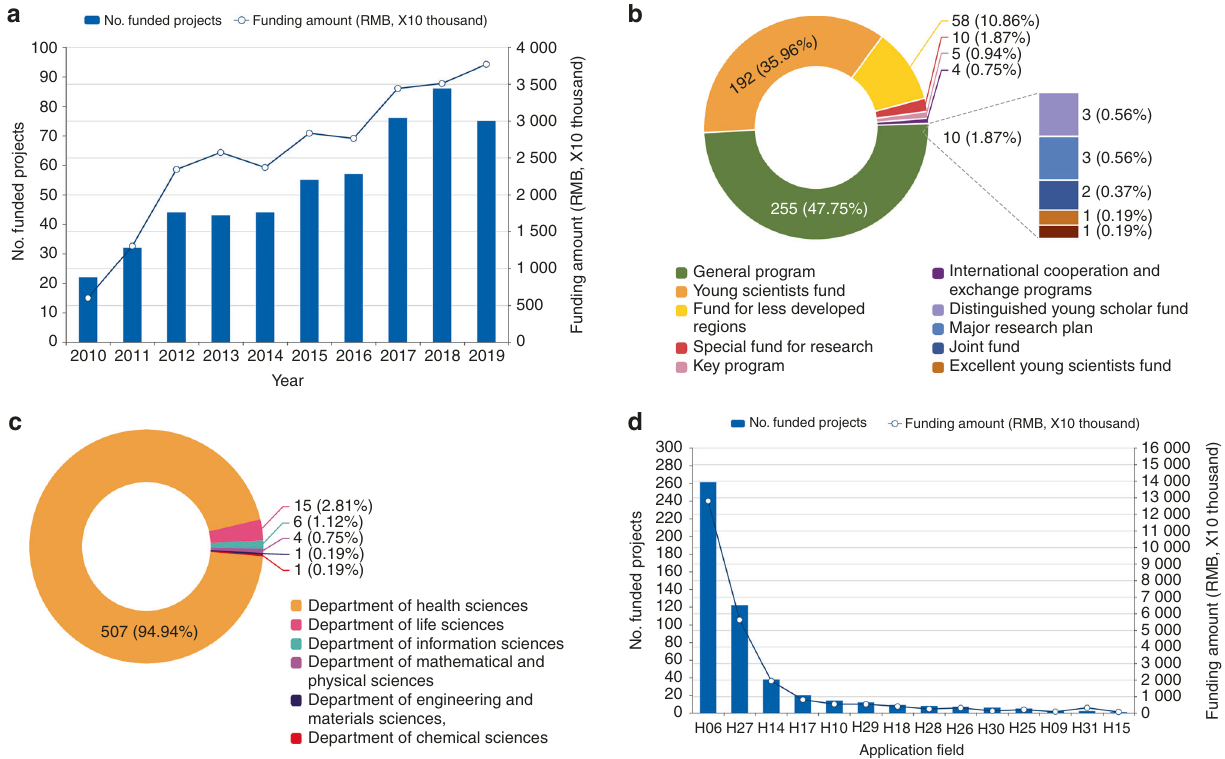
Fig. 1 Statistics for the situation of funding in the fi eld of OA provided by the NSFC in China (2010-2019). a The annual number of funded projects and their gross funding amounts. b The number of funded projects related to OA by the different project types. c Comparison of different departments of the NSFC involved in OA research. d The rank of codes initiating grants for the study of